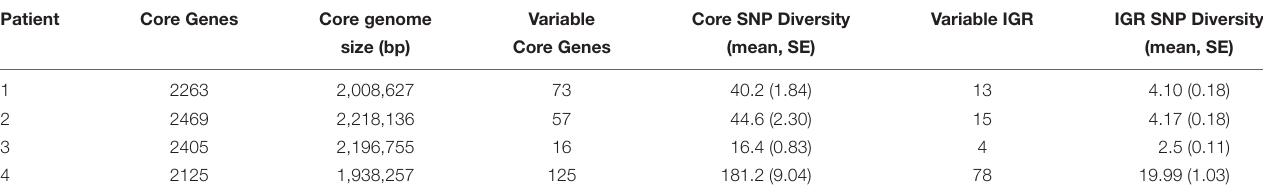
TABLE 2 | Intrahost core-genome and intergenic (IGR) diversity of clonal Staphylococcus aureus isolates. Patient